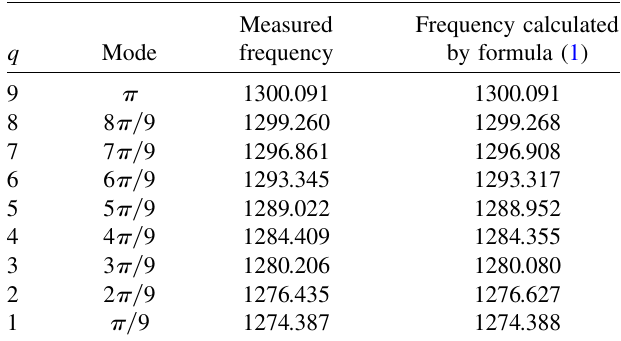
TABLE I. Passband frequencies (MHz) of ILC